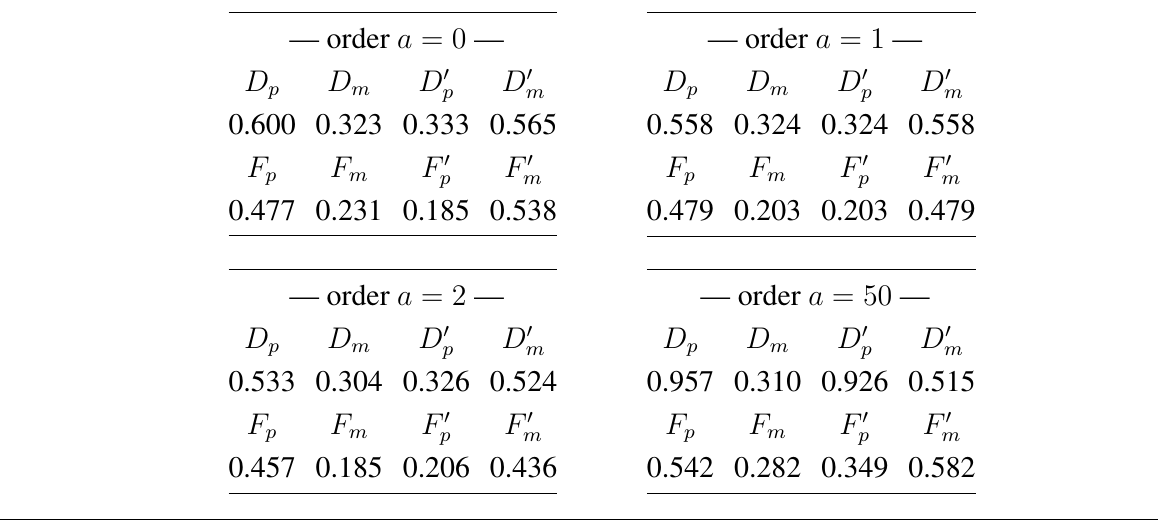
to the frequencies that underly the illustration a